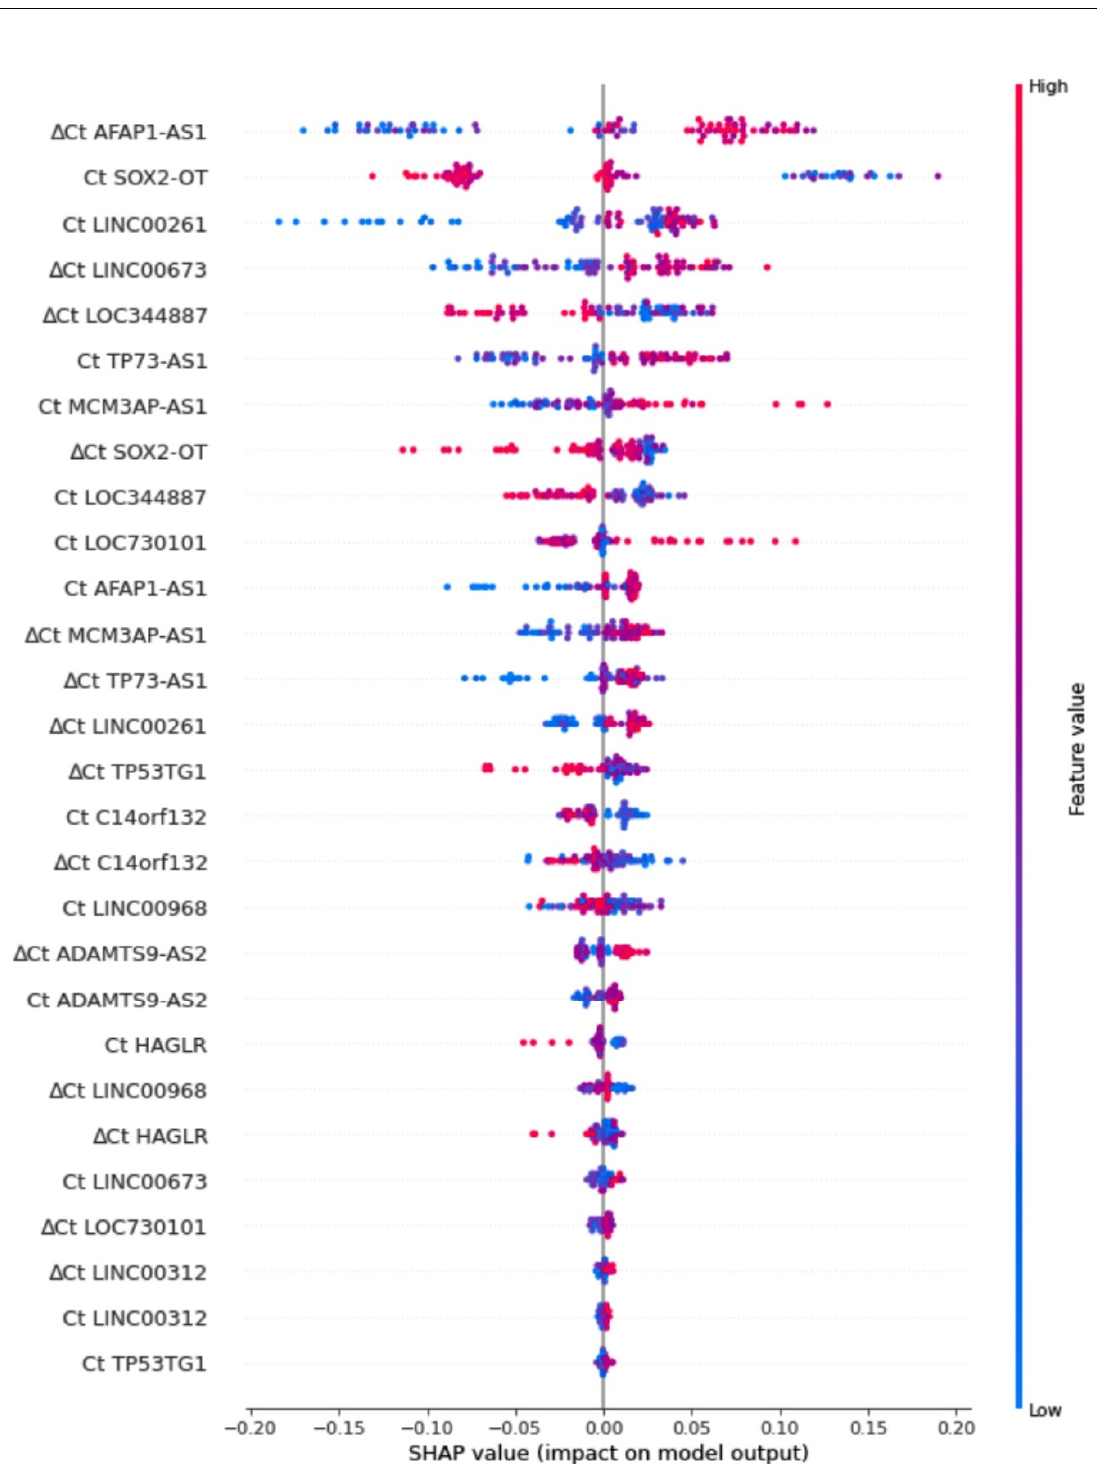
Figure 4. Shapley Additive Explanation for the gradient boosting decision tree classifier. The y-axis indicates a ranking of variables, Ct and delta Ct values of lncRNAs, sorted from the most important in the model (top) to the least important (bottom). The x-axis indicates an impact of a given variable on the model’s predictions; the SHAP values are sorted from the negative impact leading towards the LUAD subtype (class 0 on the left) to the positive impact leading towards the LUSC subtype (class 1 on the right). There are 92 points per row, one point per patient, where each indicates an attribution of a given variable to the probability model output. The color-axis indicates the variables’ values from low with blue to high with red. The visible distinction in colors between negative and positive SHAP values might be viewed as indicating a significant expression profile (up or down).